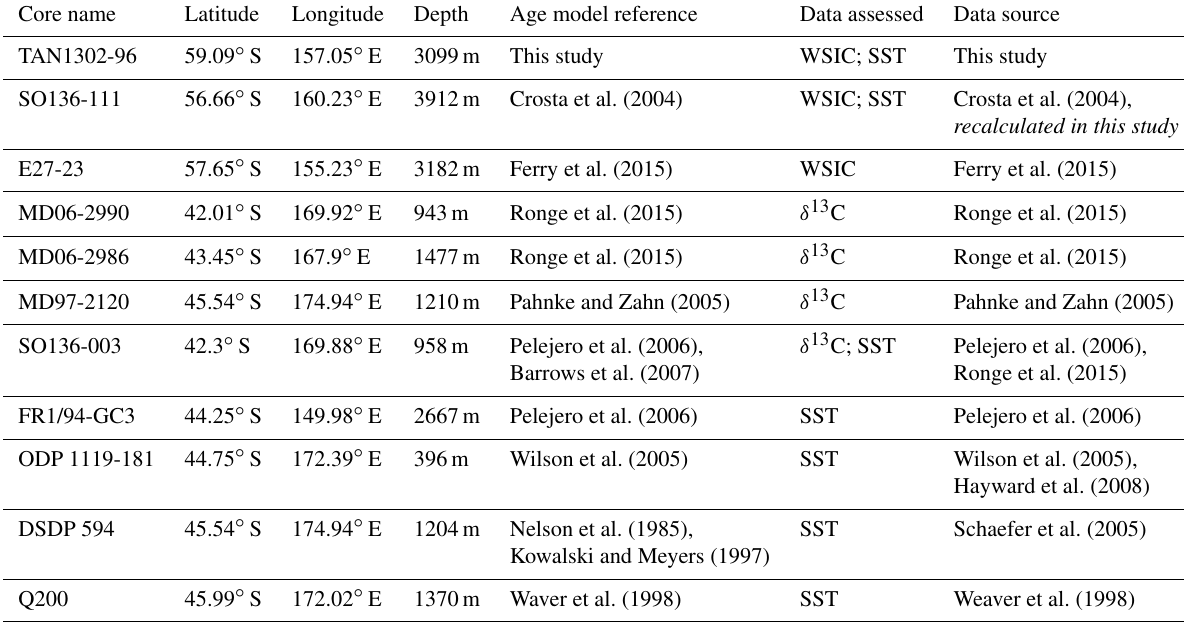
Table 2. Additional data on published marine cores used throughout this